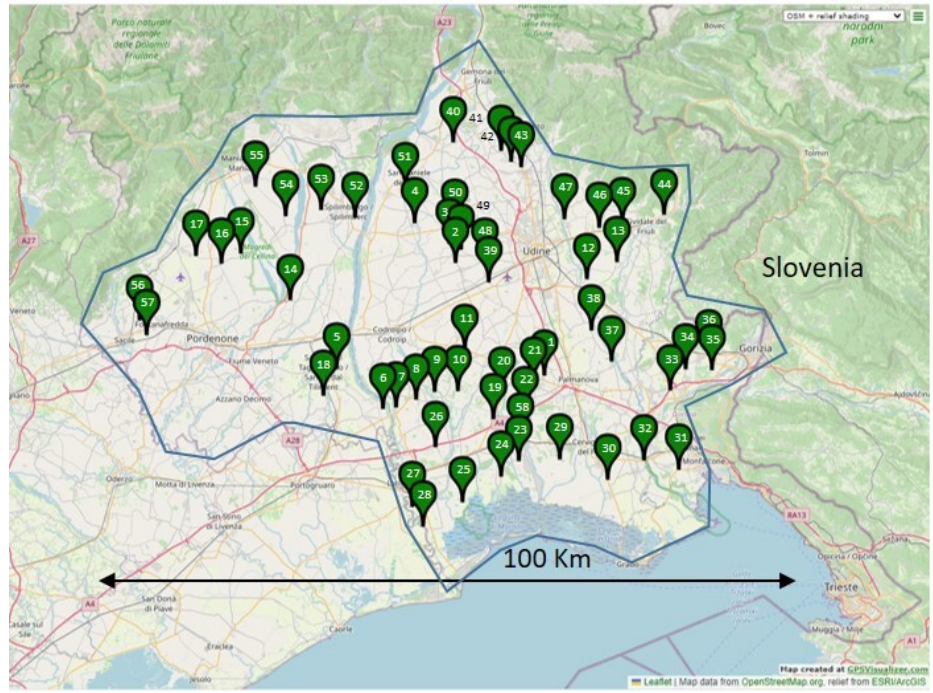
Figure 5. Sampling sites of the 58 Amaranthus spp. accessions. The blue line approximately represents the 3000 km 2 area coved by the monitoring. Accession 58 was collected in 2012, while all the others in 2018. The susceptible check (17–53) is not visible as it was collected outside this area. The map was designed with the online tool GPS Visualizer [16].